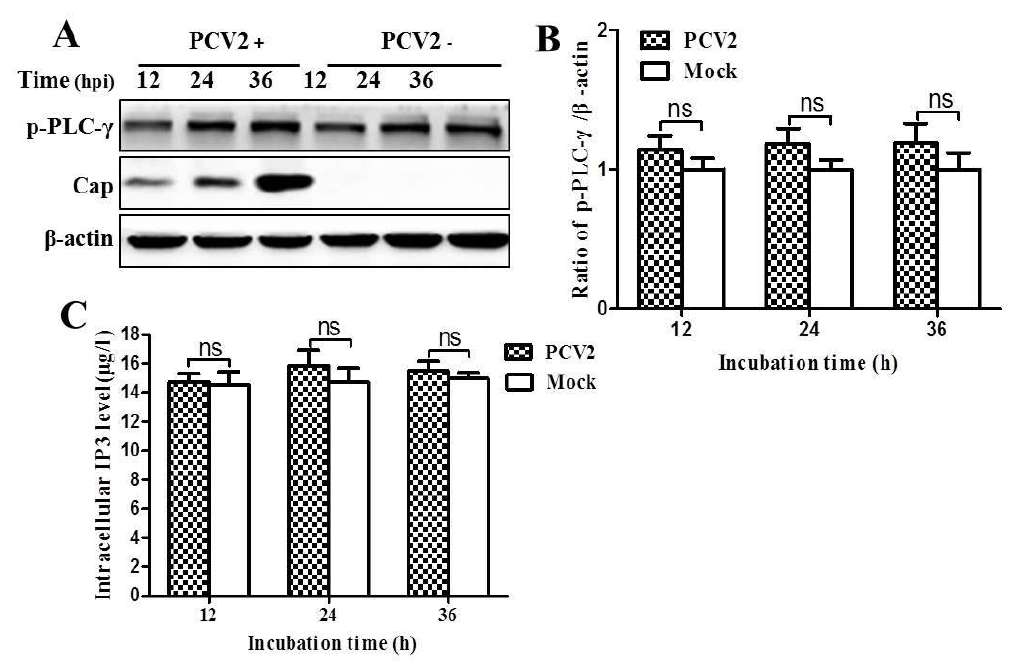
Figure 8. PCV2 infection did not affect phosphorylation of phospholipase C-gamma (PLC-γ), neither the level of IP3. PK-15 cells were infected with PCV2 (MOI ≈ 1) for the indicated time points and then subjected to ELISA for intracellular IP3 measurement ( A ) or to Western blotting for phosphorylated phospholipase C-γ (p-PLC-γ), Cap and β-actin ( B ). ( C ) Ratios of p-PLC-γ to β-actin as represented by the panel B. Ratios of p-PLC-γ to β-actin were normalized to mock infection set at 1.0. Data are reported as the mean ± SEM of three independent experiments (ns, p > 0.05; * p < 0.05; and ** p < 0.01).